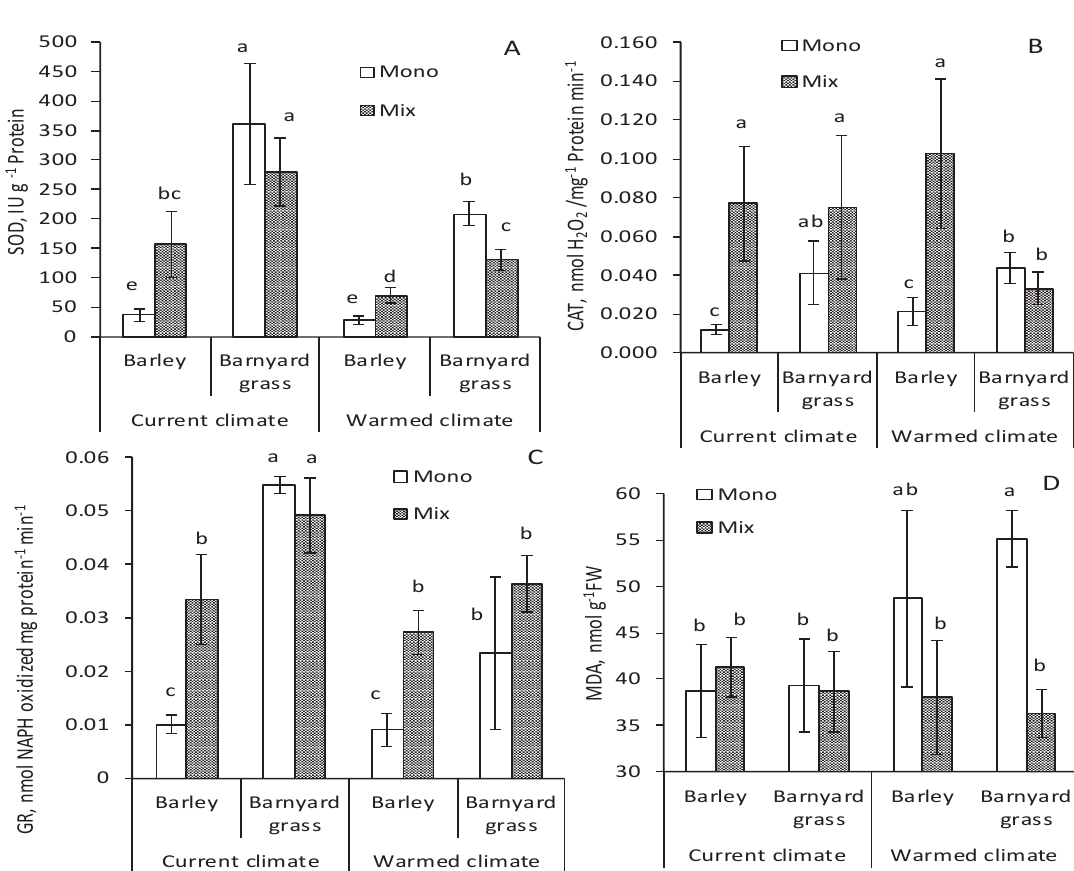
Fig. 4. The changes in the activity of superoxide dismutase (SOD) (A), catalase CAT (B) and glutathione reductase (GR) (C), and the concentration of malondialdehyde MDA (D) in barley ( Hordeum vulgare L.) and barnyard grass ( Echinochloa crus-galli L.) plant leaves grown in mono culture (Mono; 15 plants per pot) and mix culture (Mix; 9 crop plants and 6 weeds) at current (400 µmol mol -1 CO ; day/night temperatures 21/14 °C) and a warmed (800 µmol mol -1 CO ; day/night temperatures 25/18 °C) climate 2 2 conditions. Each value represents the mean ±CI (n=3). Different letters indicate significant differences at p <0.05 between the treatments as determined by Least Significant Differences (LSD)